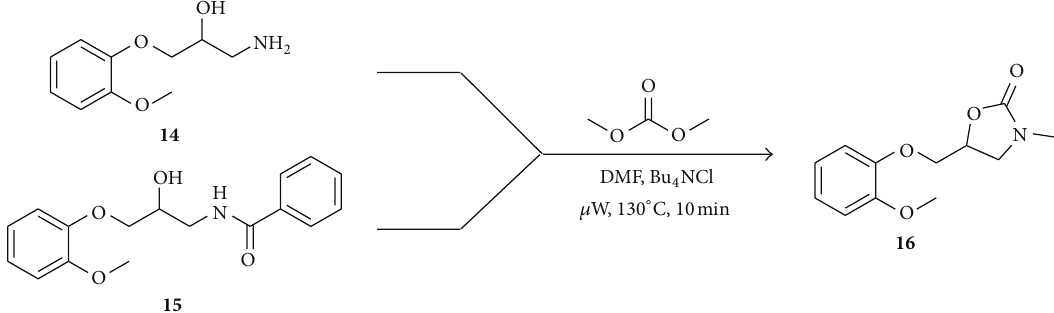
Scheme 4: Reaction of secondary amino alcohols with DMC and TBAC.